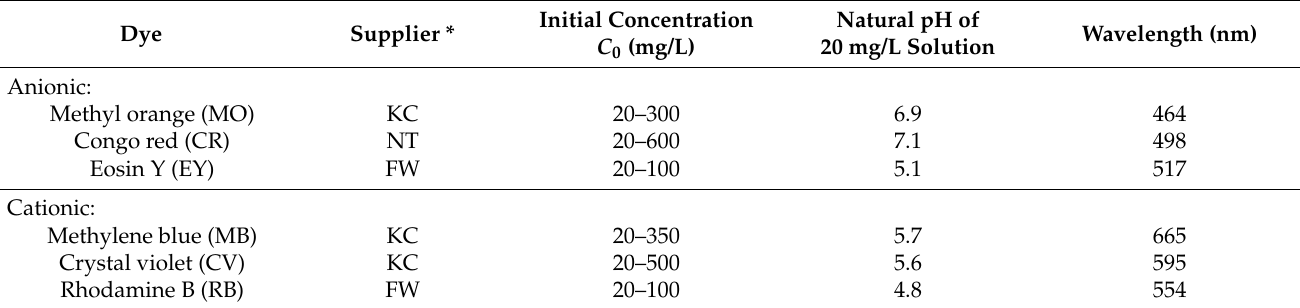
Table 1. Anionic and cationic dyes used in this